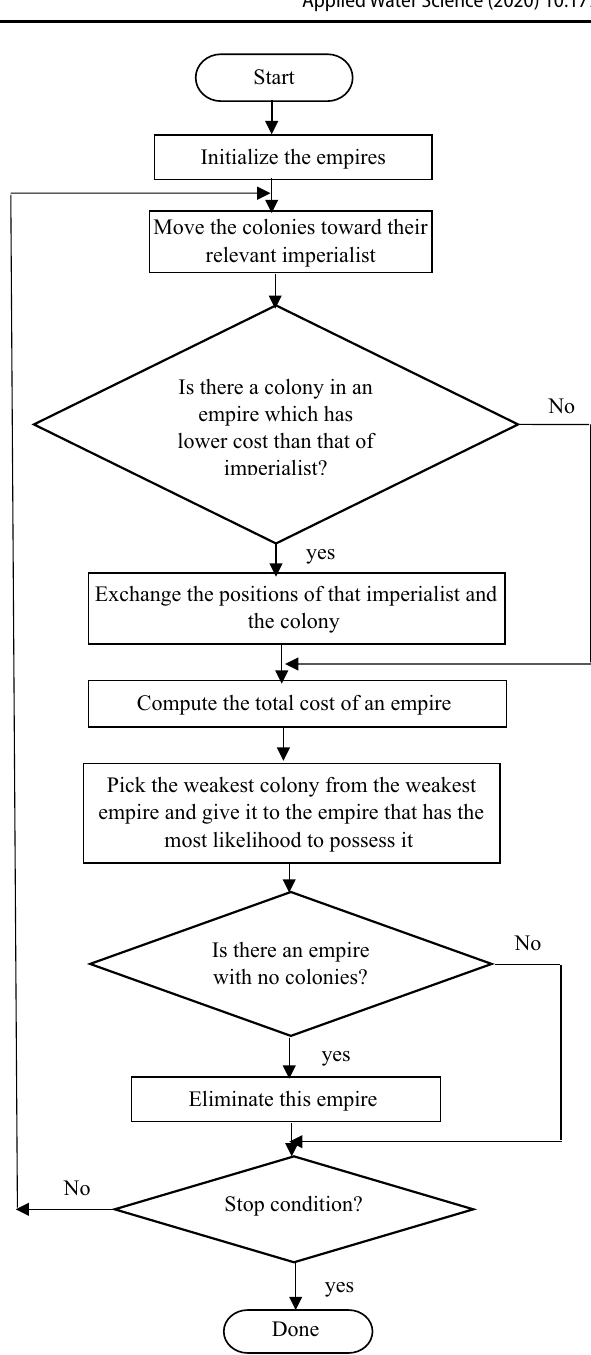
Fig. 2 Flowchart of ICA algorithm (Khalili et al.